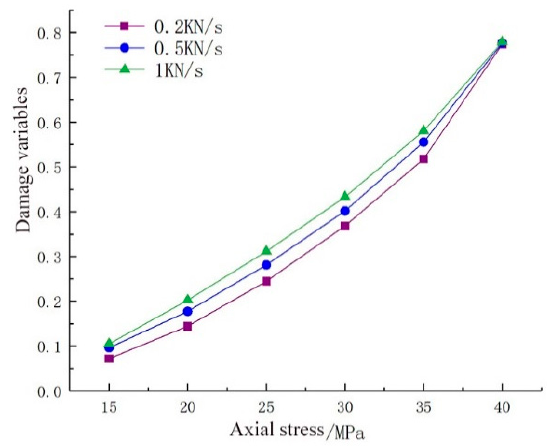
Figure 12. Damage evolution curve.